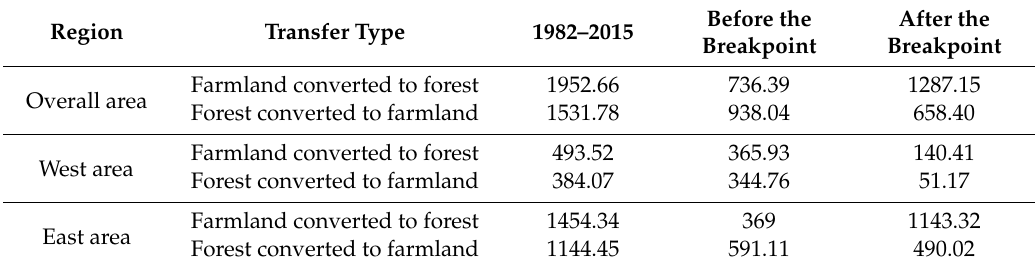
Table 2. Conversion of farmland and forest before and after the breakpoint in the entire area, the west area, and the east area (km 2